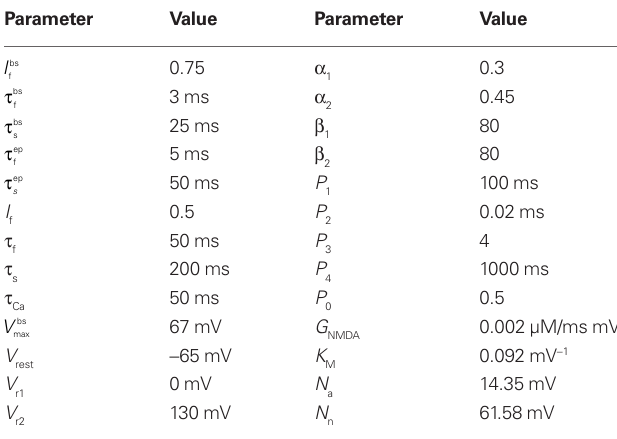
Table 1 | Parameter values of the synaptic